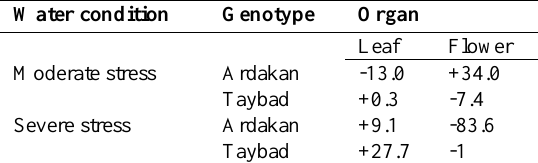
Table 4 . Reduction or increment percentage of β- Acoradiene and γ-Terpinene relative to normal (control) condition in leaf and flower tissues,